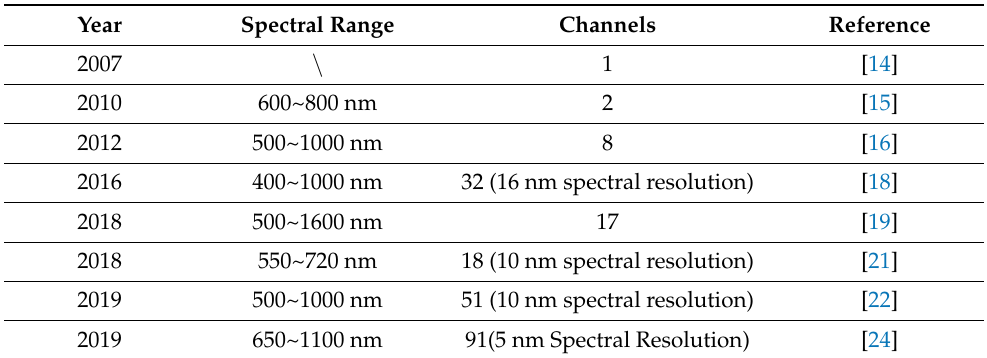
Table 1. Supercontinuum laser HSL